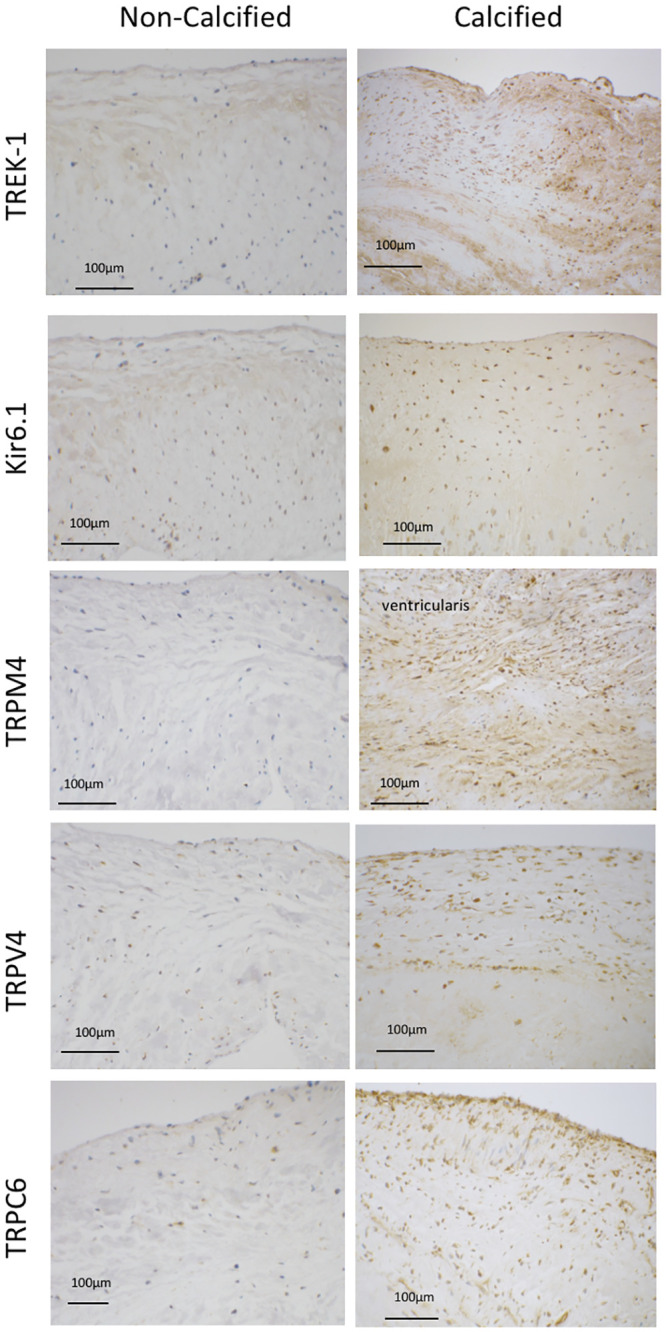
Representative images of immunohistochemical localisation of mechanosensitive ion channel in non-calcified and calcified aortic valve cusp tissue.Tissue sections were stained with antibodies against MSCK TREK-1 and Kir6.1, and against MSCNS TRPM4, TRPV4, and TRPC6. Signal (brown staining) from each antibody was assessed on sections from 8–10 individual valves. The sections are orientated with the ventricularis at the top of each section.